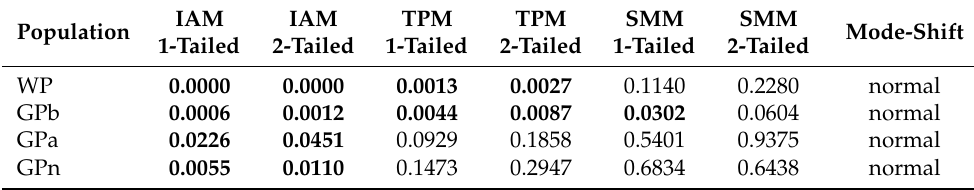
z Boldface indicates significance ( p < 0.05) in tests either 1-tailed (for heterozygosity excess) or 2-tailed (for heterozygosity excess or deficit) under infinite allele model (IAM), two-phase mutation (TPM) or stepwise mutation model (SMM). Mode-shift is a graphical descriptor of the allele frequency distribution which distinguishes bottlenecked over stable populations.